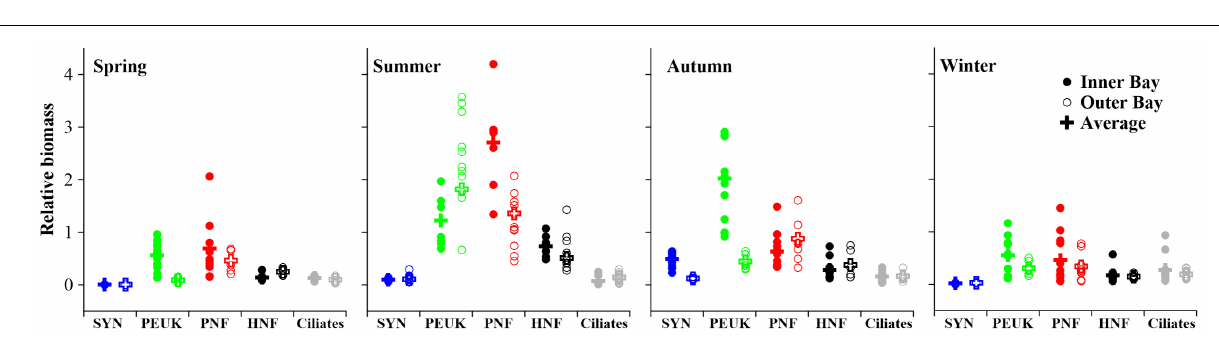
FIGURE 9 | Microbial food web structures in Inner and Outer Sanggou Bay in four successive seasons, spring to winter. The Inner and Outer Bay boundary were shown as solid lines in Figure 8 . Relative biomasses of MFW components were normalized by heterotrophic prokaryotes biomass belonging to the same sample. SYN, Synechococcus ; PEUK, phototrophic picoeukaryotes; PNF, pigmented nanoflagellates; HNF, heterotrophic